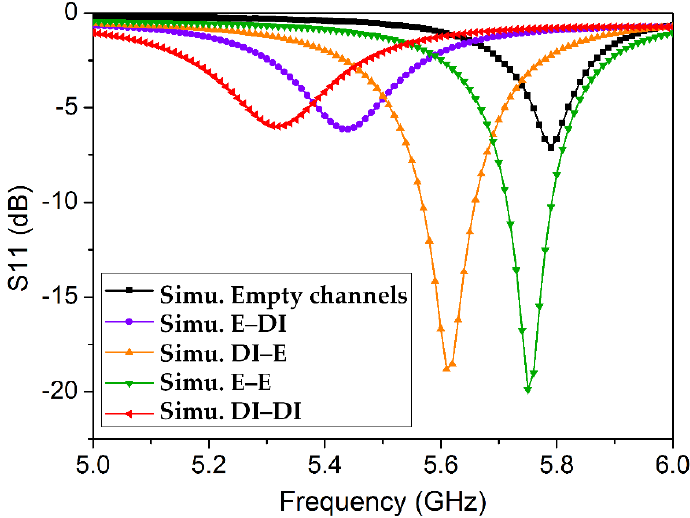
Figure 8. Return loss (simulated) for empty channels and four possible combinations of ethanol (E) and DI water (DI) in the channels, loaded onto the TM 02 -mode QMSIW resonator.